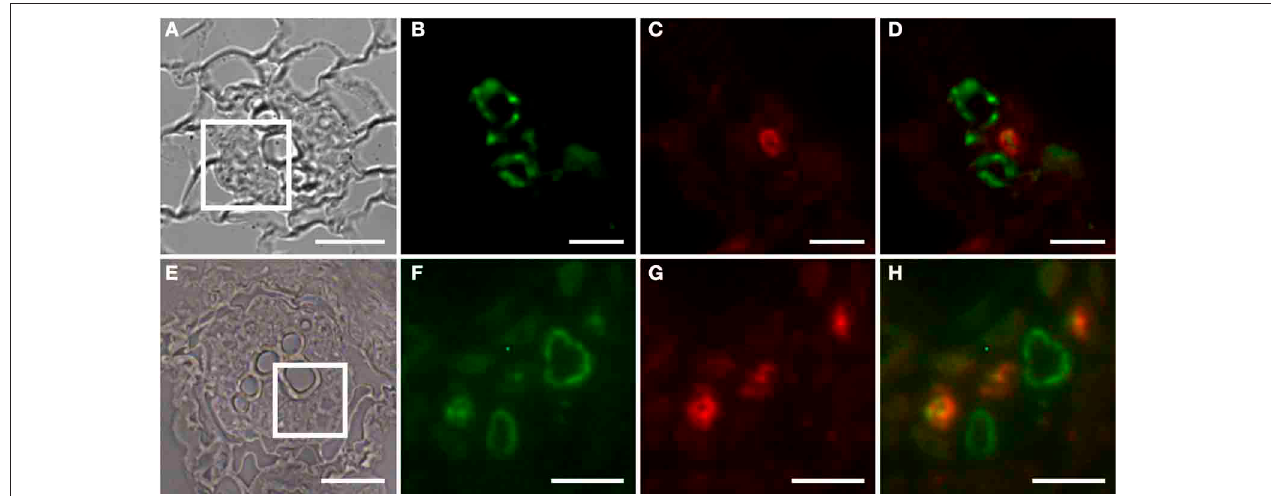
FIGURE 2 | Identification of auxin responsive cells by immunohistochemistry in sections through roots of 2-week old P DR5 :ER - GFP Arabidopsisplants.(A–D) Sectionthrougharootapproximately 2cm above the root tip corresponding to the part of the root in which early giant cell developmentoccurs. (E–H) Section through a slightly older part of the root. (B–D) and (F–H) are details of (A) and (E) , respectively, indicated by